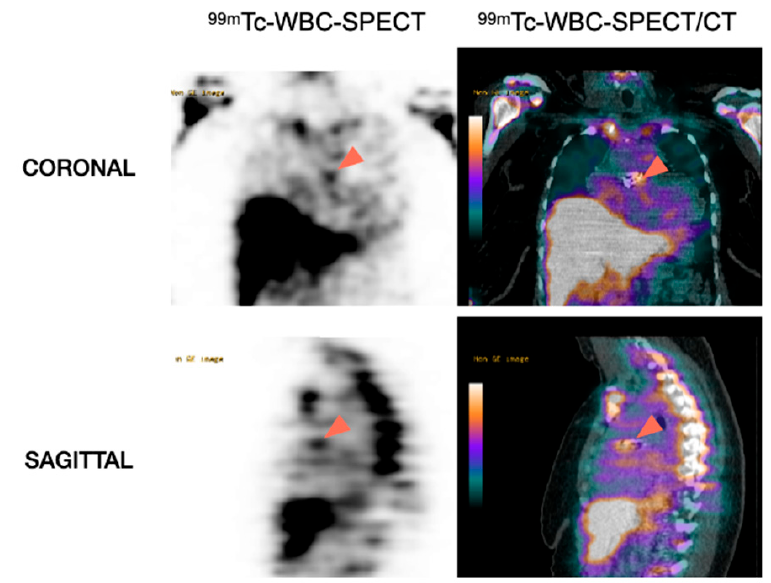
Figure 4. Role of WBC-SPECT/CT for the detection of prosthetic valve endocarditis. Note the accumulation of 99m Tc-labeled WBC in the region corresponding to the aortic prosthetic valve (arrowheads) in favor of PVE.